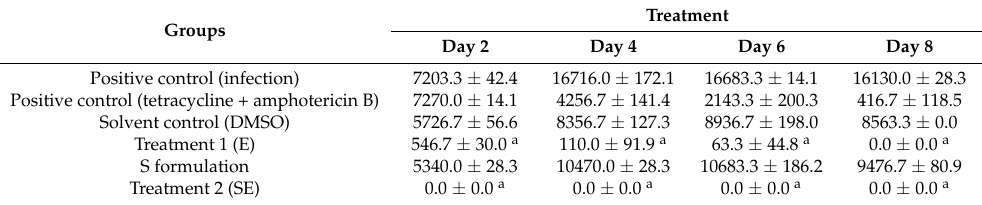
Table 6. Fungal loads (CFUs) obtained from the culture of vaginal fluid collected during the treatment period for therapeutic treatment against CAV3.